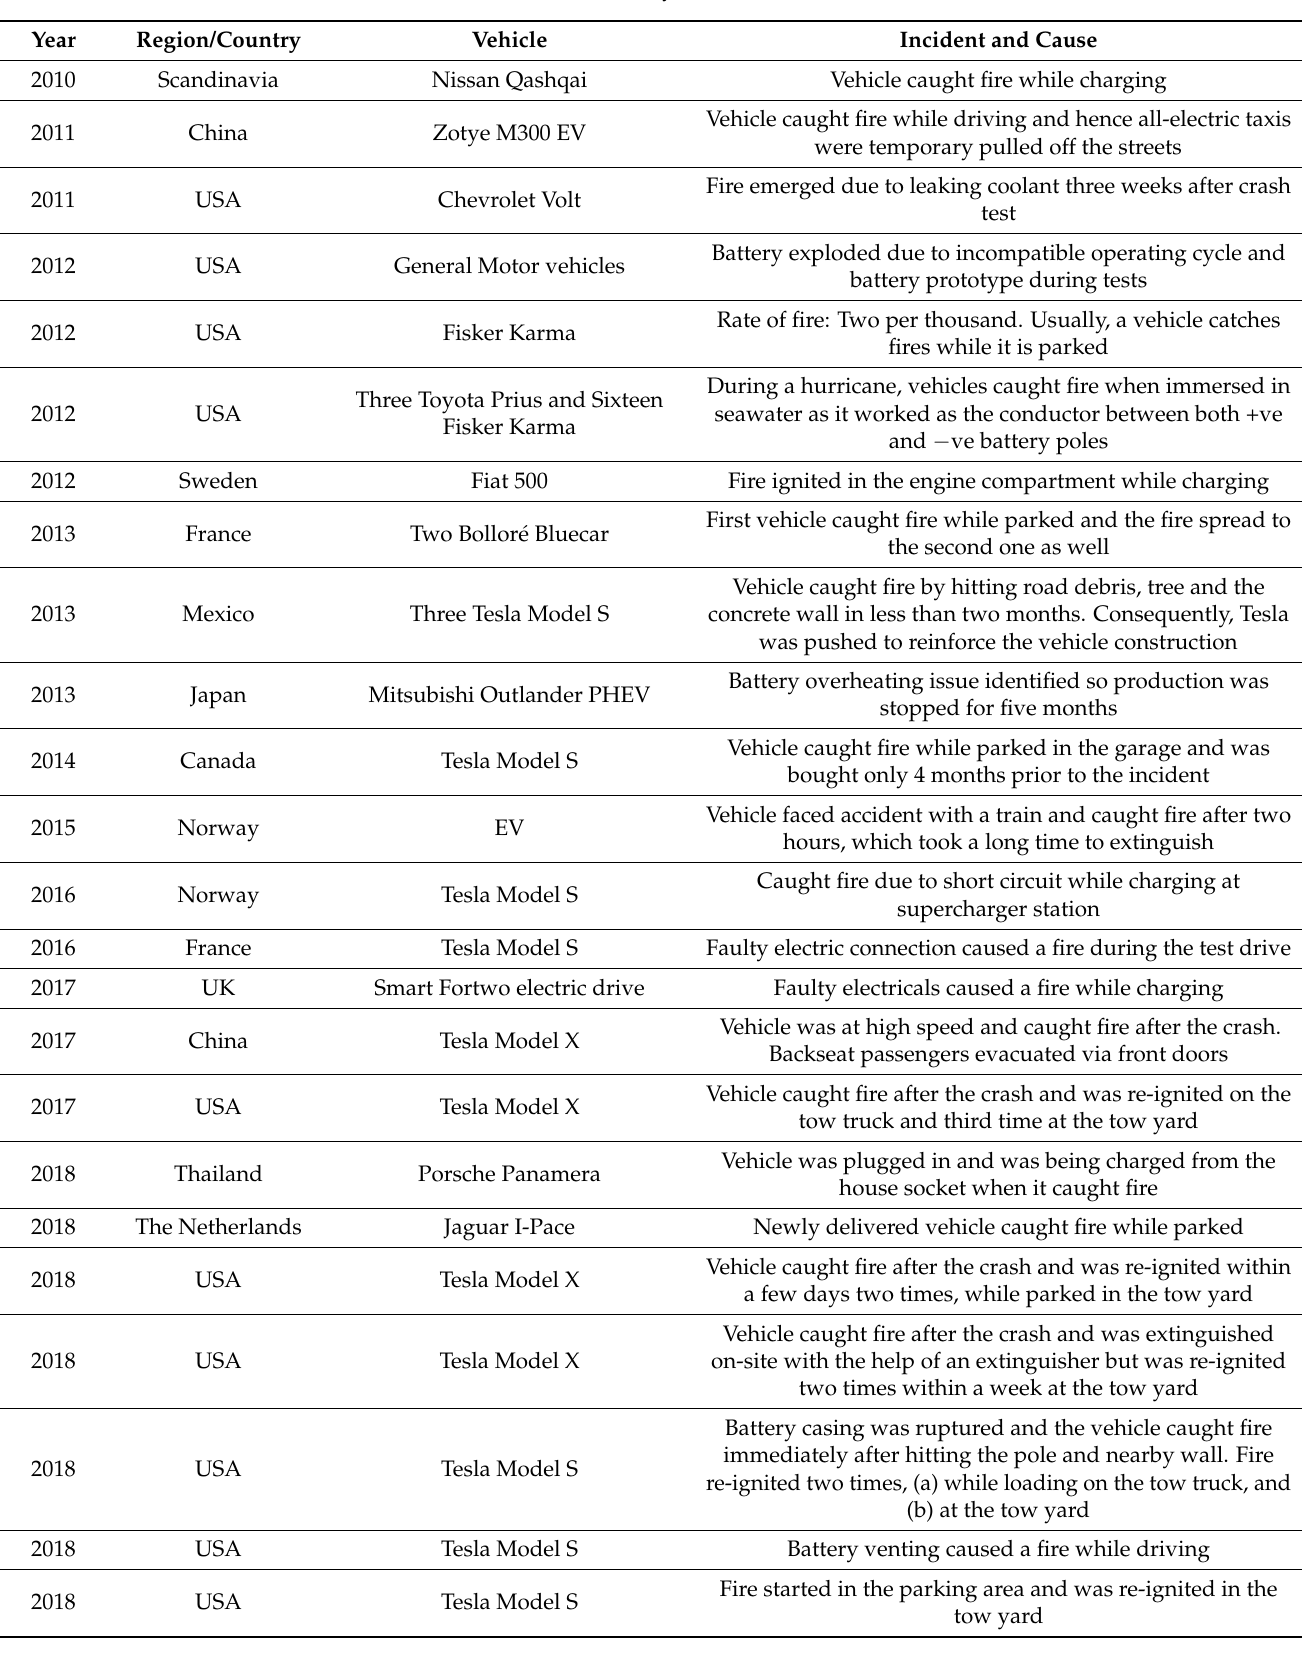
Table 1. List of battery incidents